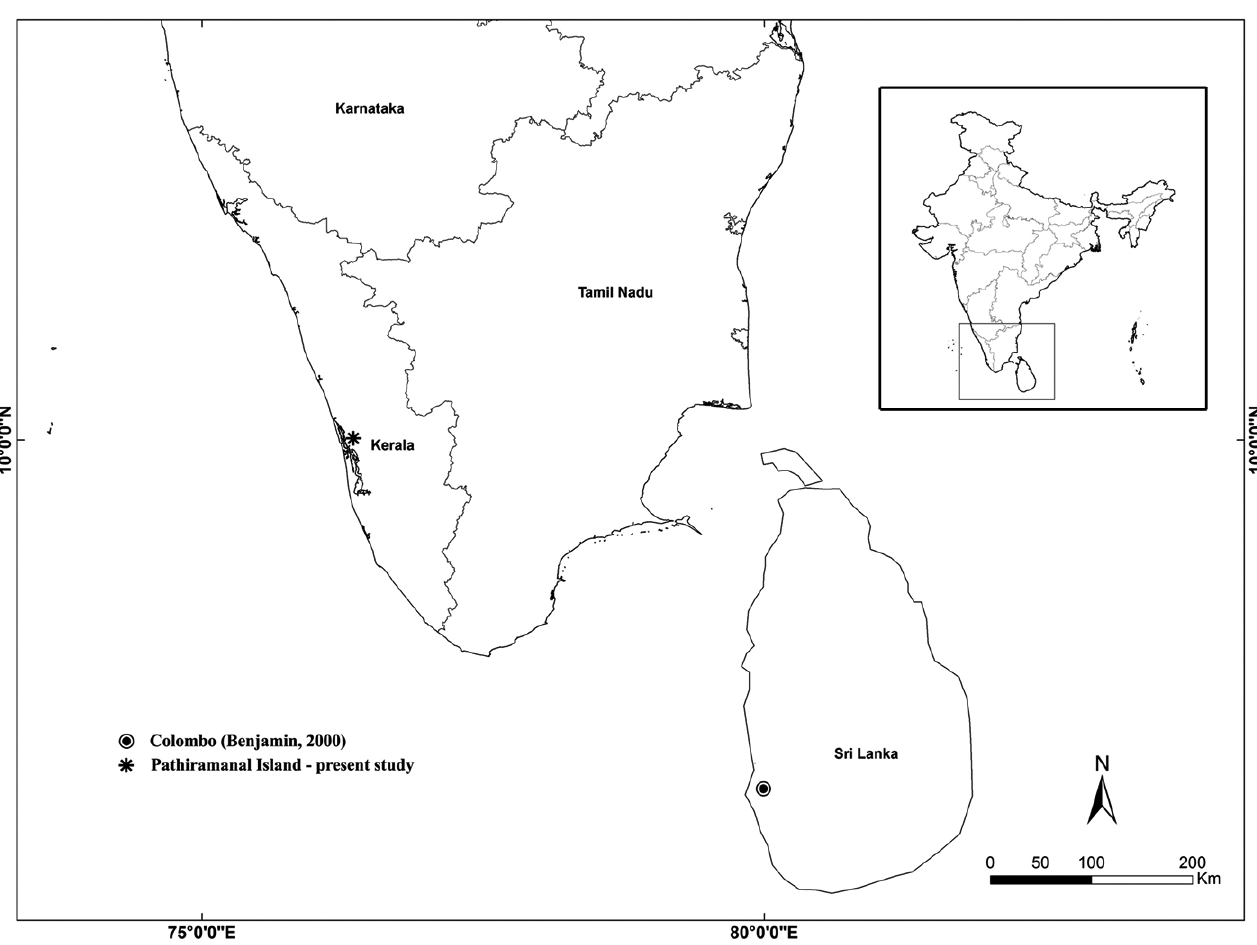
Figure 3 . Distribution map of Epidius parvati Benjamin,